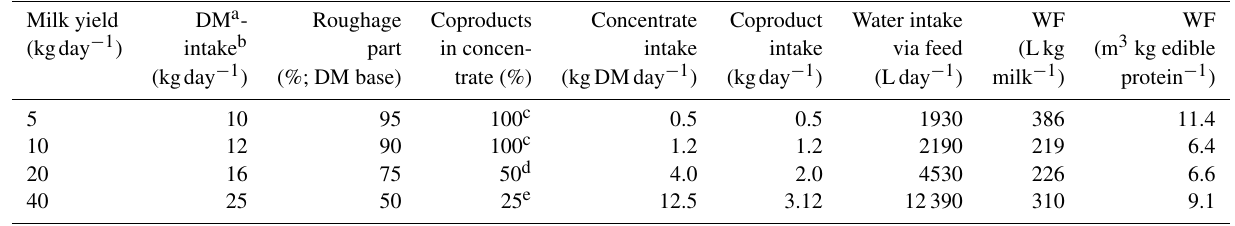
Table 10. Model calculation of water footprint (WF) for milk depending on milk yield and coproducts in feeding. Milk yield DM a - Roughage Coproducts